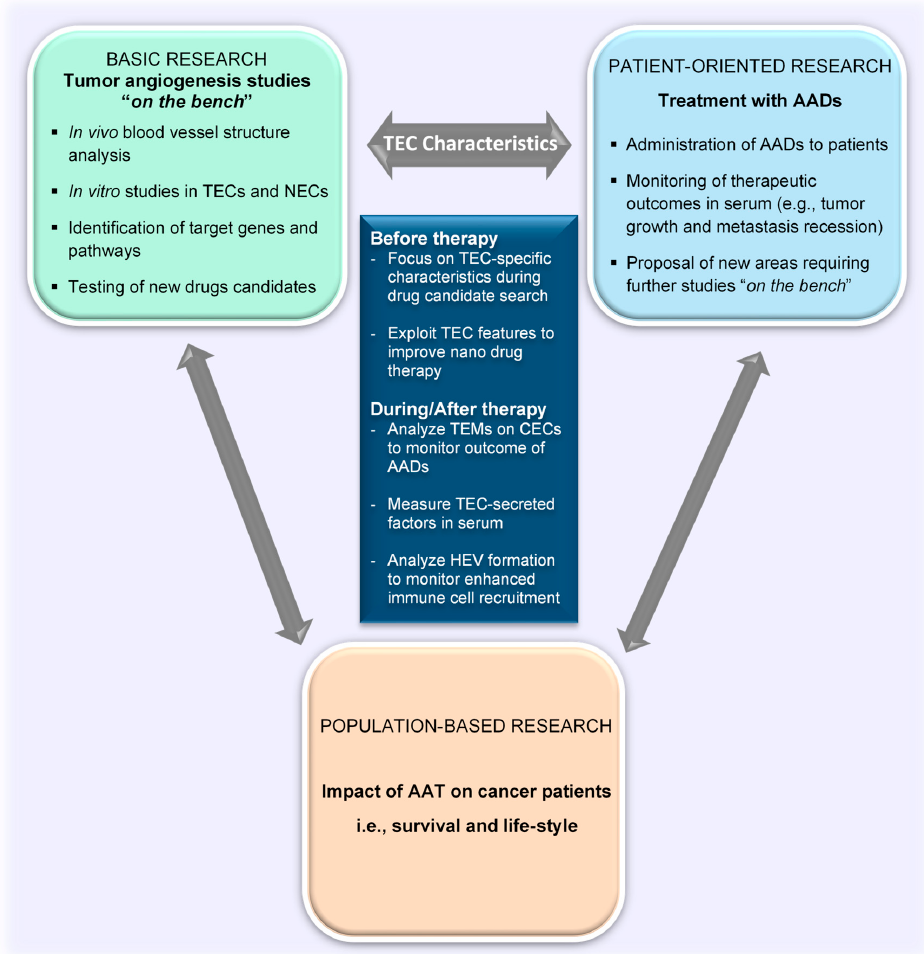
AATs, antiangiogenic